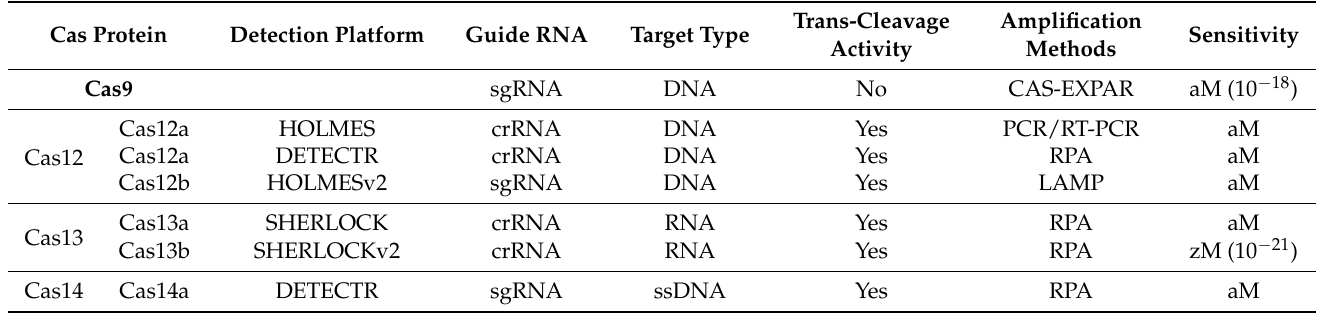
Table 4. Application of the CRISPR system in pathogen detection.